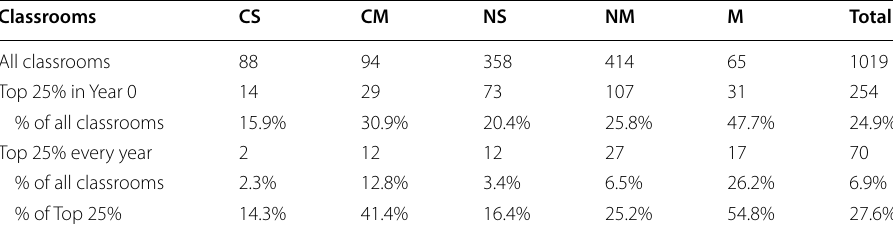
CS commercial single, CM commercial multi, NS non-profit single, NM non-profit multi, M municipal